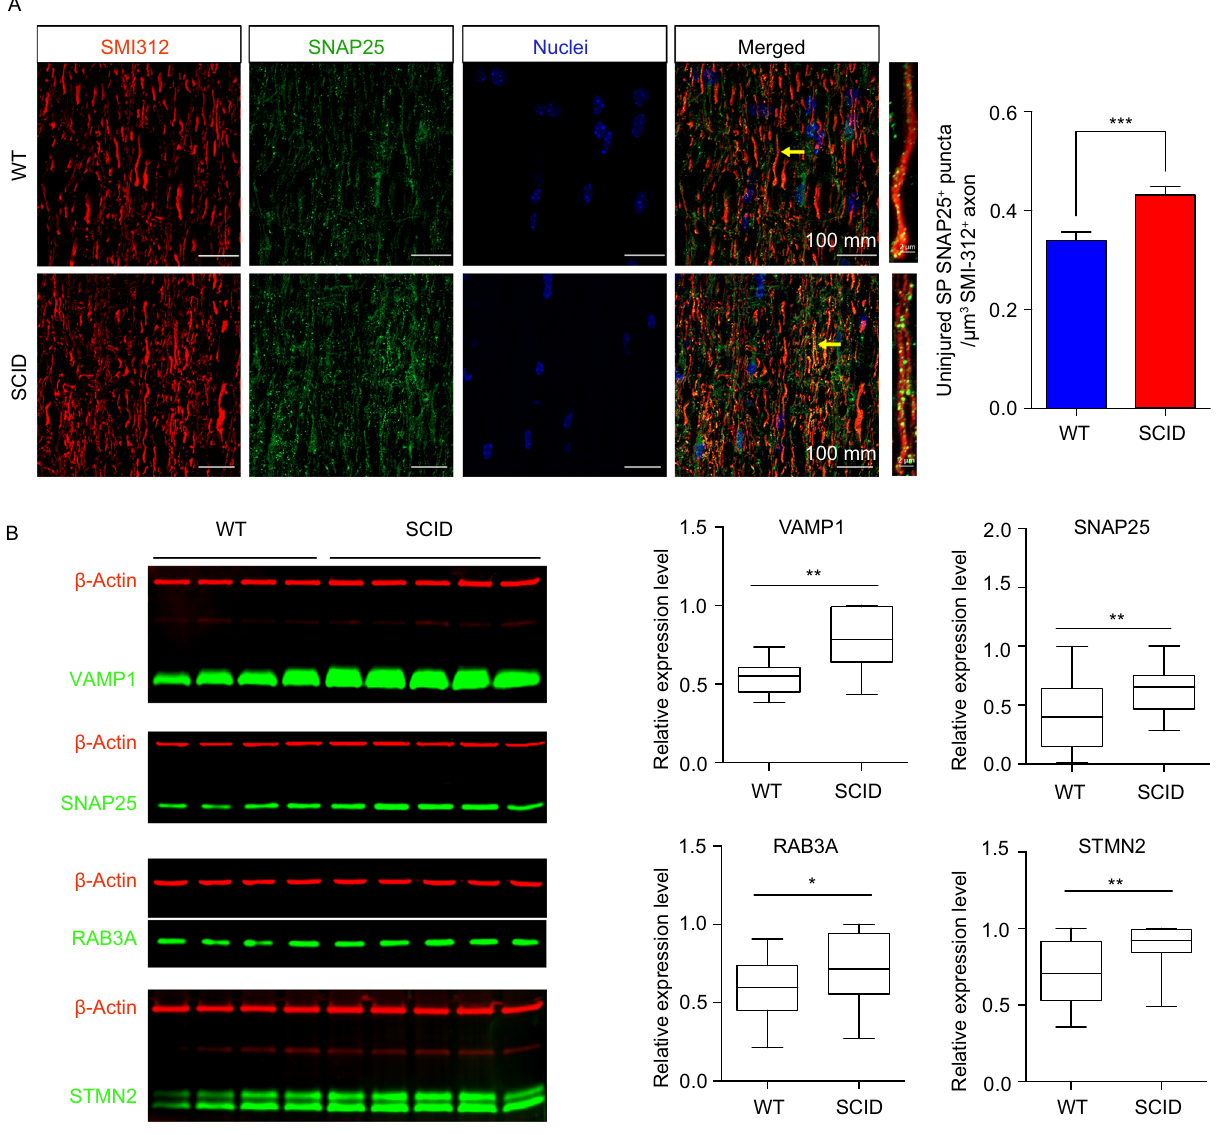
Figure 5. Uninjured SCID mice displayed boosted synaptic transmission program. (A) Immunostaining of SNAP25 and SMI- 312 in WT/SCID uninjured spinal cord samples with high magni fi cation images of indicated areas presented to the right. SNAP25 + puncta within SMI-312 + labeled axons (per µm 3 ) of uninjured samples in the equivalent location as injured samples were measured (mean±SEM; n ≥ 20, *** P <0.001, Mann Whitney test). (B) Western blotting analysis of blue module hub genes VAMP1, SNAP25, RAB3A, STMN2 and β -actin protein levels of uninjured spinal cord sample from WT and SCID mice (mean±SD; n =4 (WT), n =5 (SCID), * P <0.05, ** P <0.01, unpaired Student ’ s t